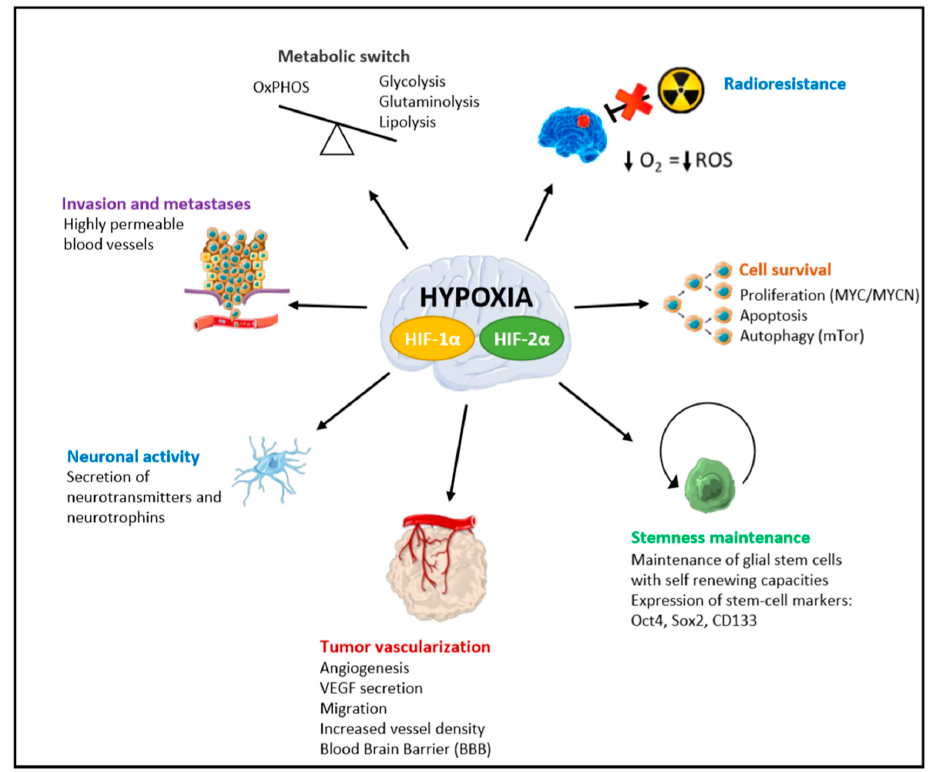
Figure 3. E ff ects of Hypoxia-Inducible Factors’ (HIF-1 α and HIF-2 α ) hyperexpressions in pediatric high-grade gliomas. HIFs have a specific role in metabolism, radioresistance, cell survival and stemness maintenance, but also in vascularization, neuronal activity and pHGG cell migration. (OxPHOS = mitochondrial oxidative phosphorylation system, ROS = Reactive Oxygen Species).